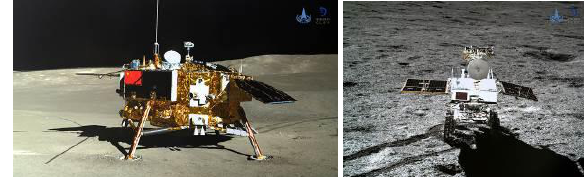
Figure 1. Photos of the CE-4 lander and rover taken by each other on January 11,